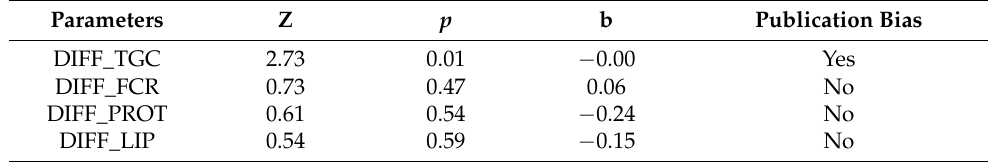
Table 1. Funnel Asymmetry Tests.